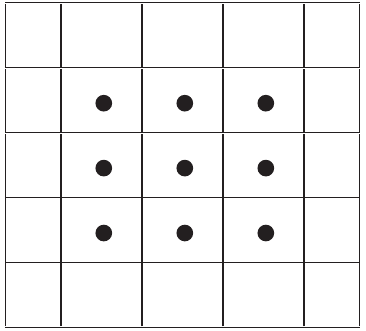
Figure 5: Moore neighborhood structure for two-dimensional CA.